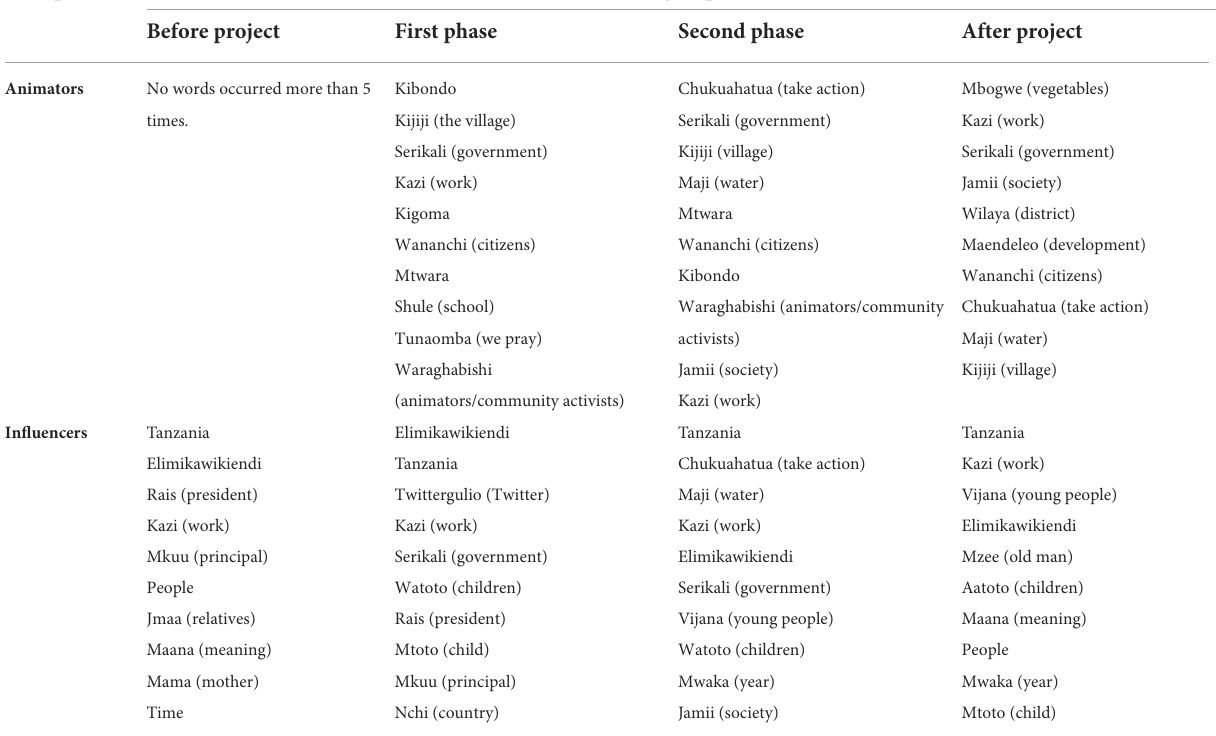
TABLE 4 Most frequent words per group and project phase. Group Project